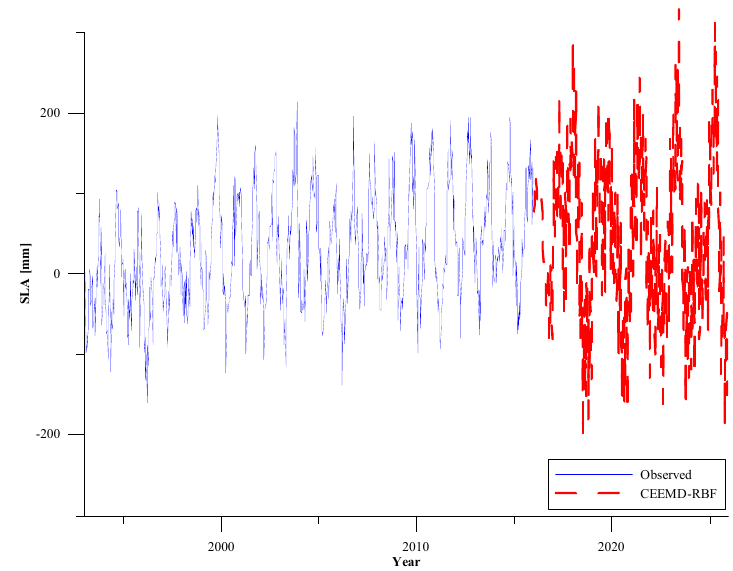
Figure 8. Estimated SLAs with CEEMD-RBF combined model from 2016 to 2025 in the Yangtze River Estuary coastal area.